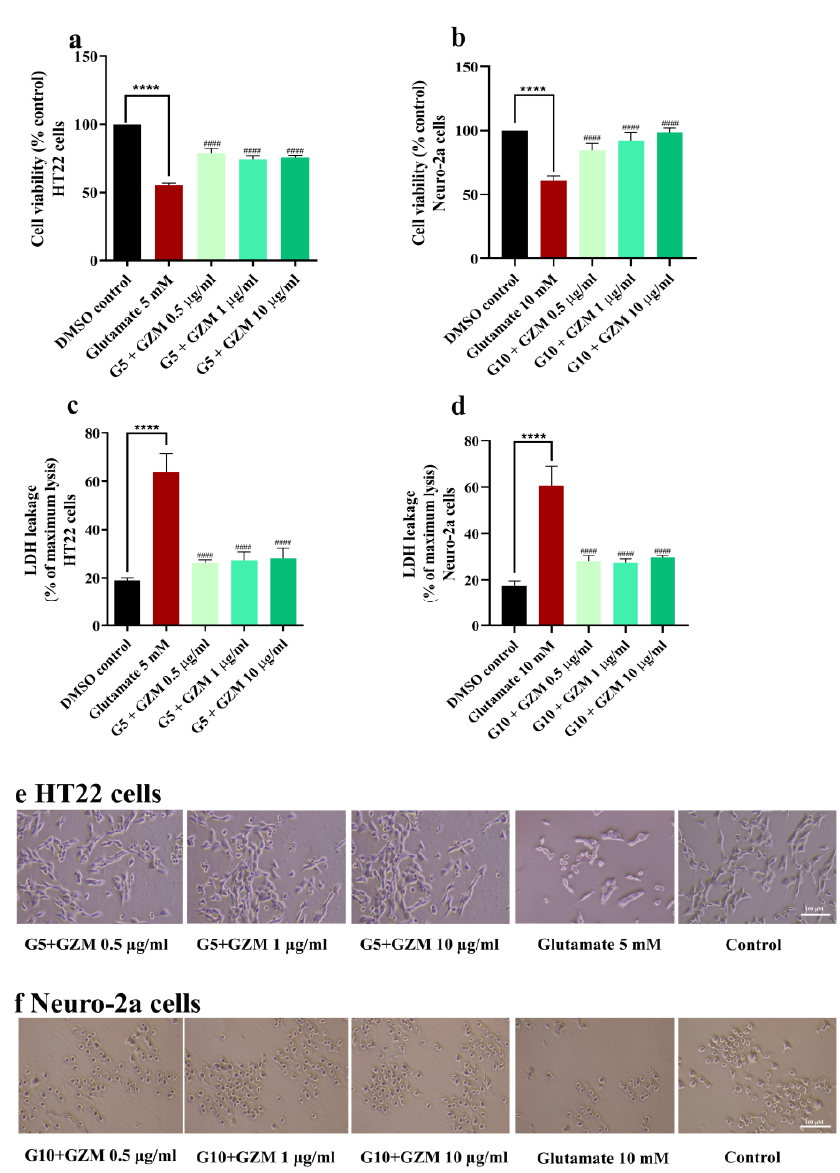
Figure 3. Neuroprotective effect of GZM extract against glutamate-induced toxicity in HT22 and Neuro-2a cells. MTT and LDH methods were used to analyze cell viability of HT22 ( a , c ) and Neuro-2a cells ( b , d ) after treatment with varying concentrations of GZM extract. Cell morphology of HT22 ( e ) and Neuro-2a ( f ) were observed under a light microscope (5 × magnification). (G5 and G10 corresponds to 5, 10 mM glutamate; n = 3) **** p < 0.0001, DMSO control vs. glutamate treatment alone; #### p < 0.0001 glutamate treatment alone vs. glutamate and GZM extract treatment. The details of statistical values are provided in Table S4 (Supplementary Materials).